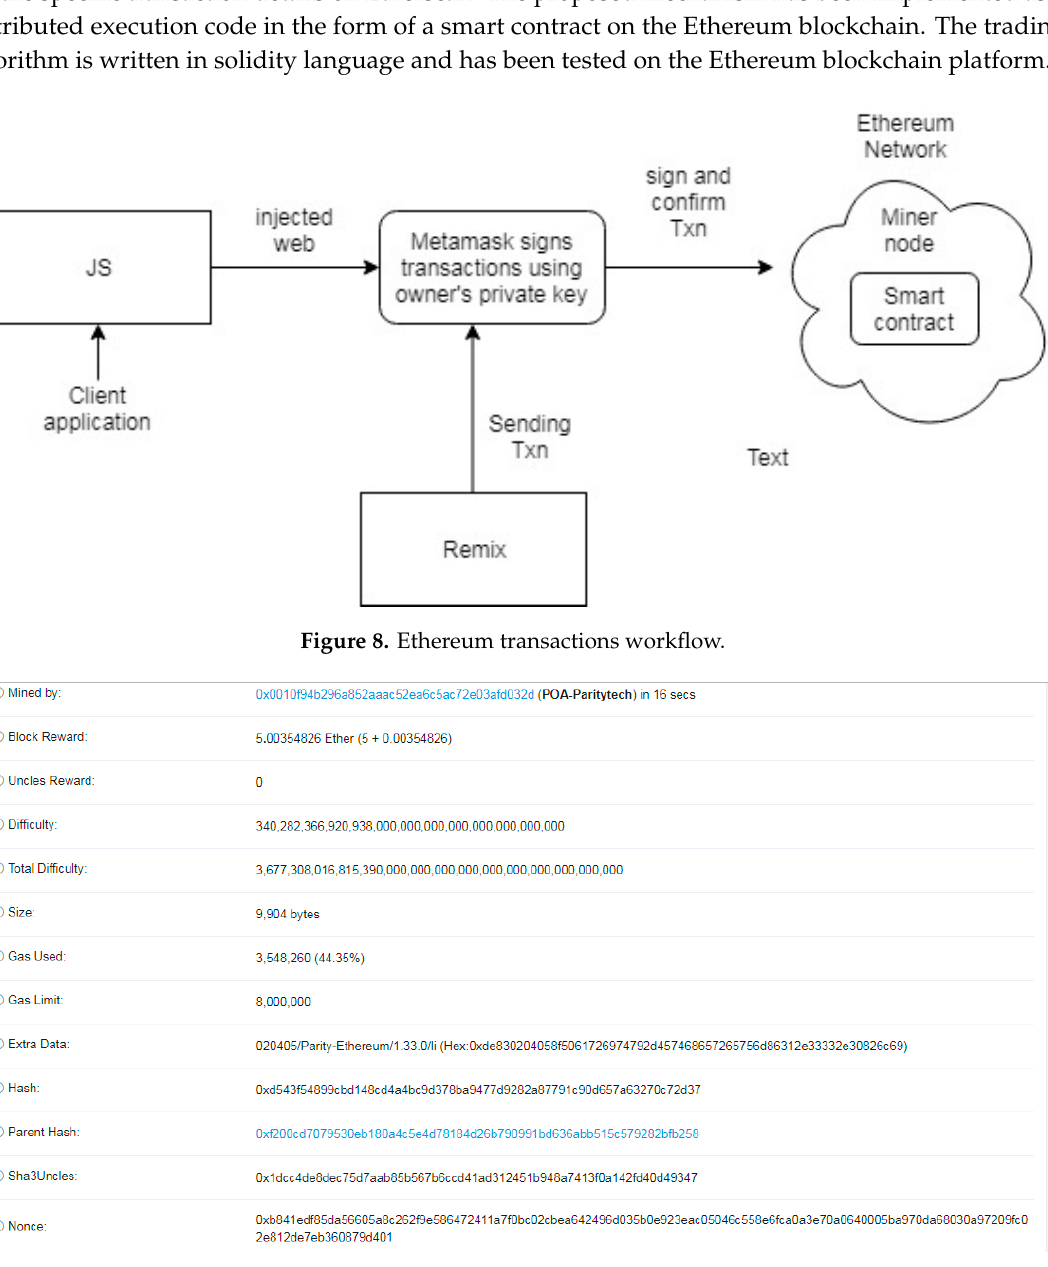
Figure 7. Components of a solidity smart contract.